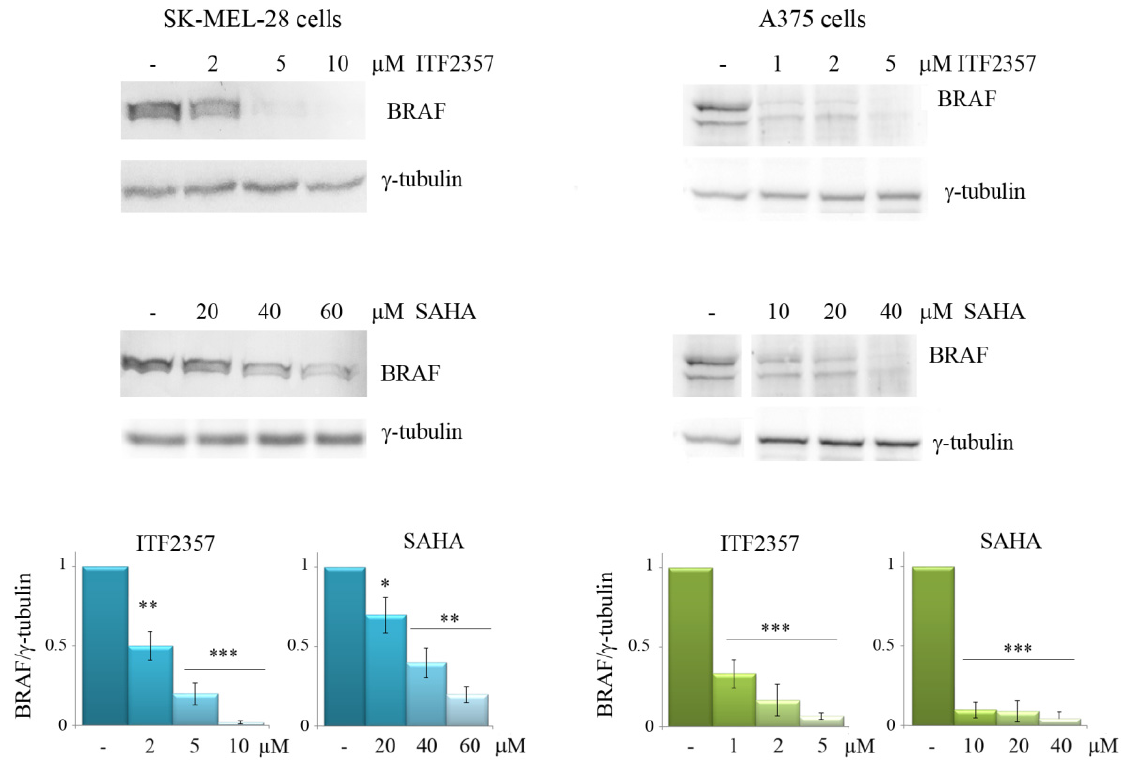
Figure 3. ITF2357 and SAHA dose-dependently decrease oncogenic BRAF levels. SK-MEL-28 and A375 cells were treated with the indicated concentrations of the two HDACI for 48 h. Western blot analysis of BRAF was performed as reported in Materials and Methods. Representative blots of three independent experiments and densitometric analysis are shown. * p < 0.05, ** p < 0.01, *** p < 0.001 with respect to untreated cells.